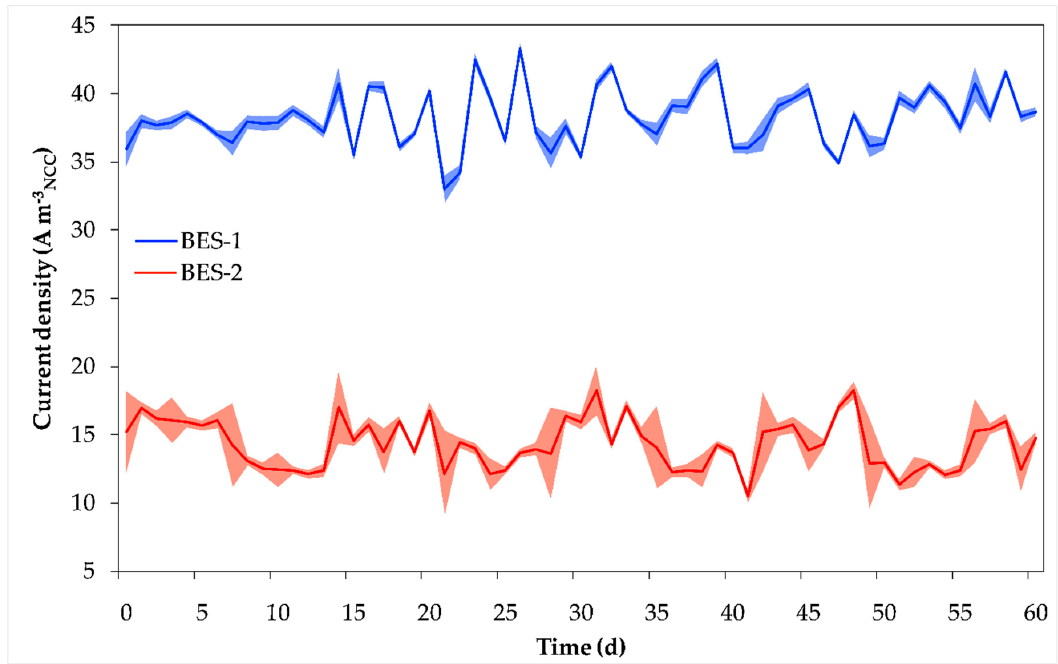
Figure 3. Current density (absolute value) measured over the whole study period. Shaded areas represent the daily standard deviation.